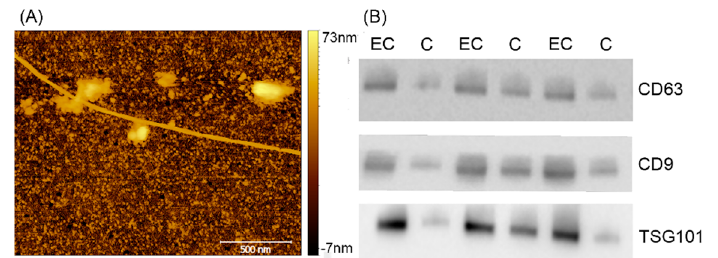
Figure 5. ( A ) Atomic Force Microscopy (AFM) imaging of endometrial serum exosome. ( B ) CD 63, CD9, and TSG101 common exosome marker. Western blotting in exosome of three C (control) and three EC (endometrial cancers).